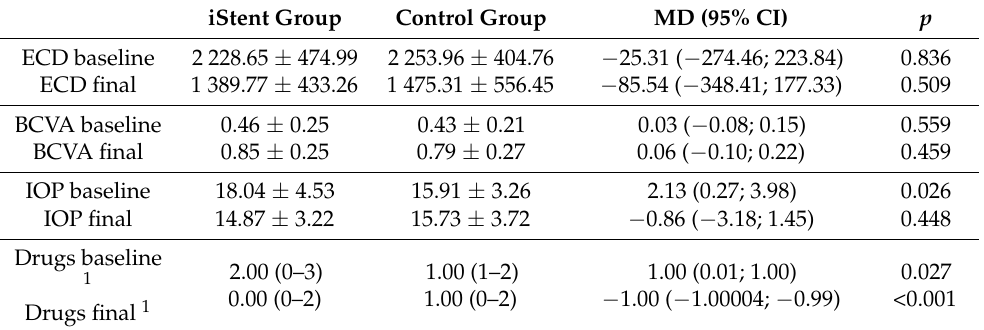
Table 2. Comparison of ECD, IOP, BCVA, and anti-glaucoma drugs between iStent and control group. iStent Group Control